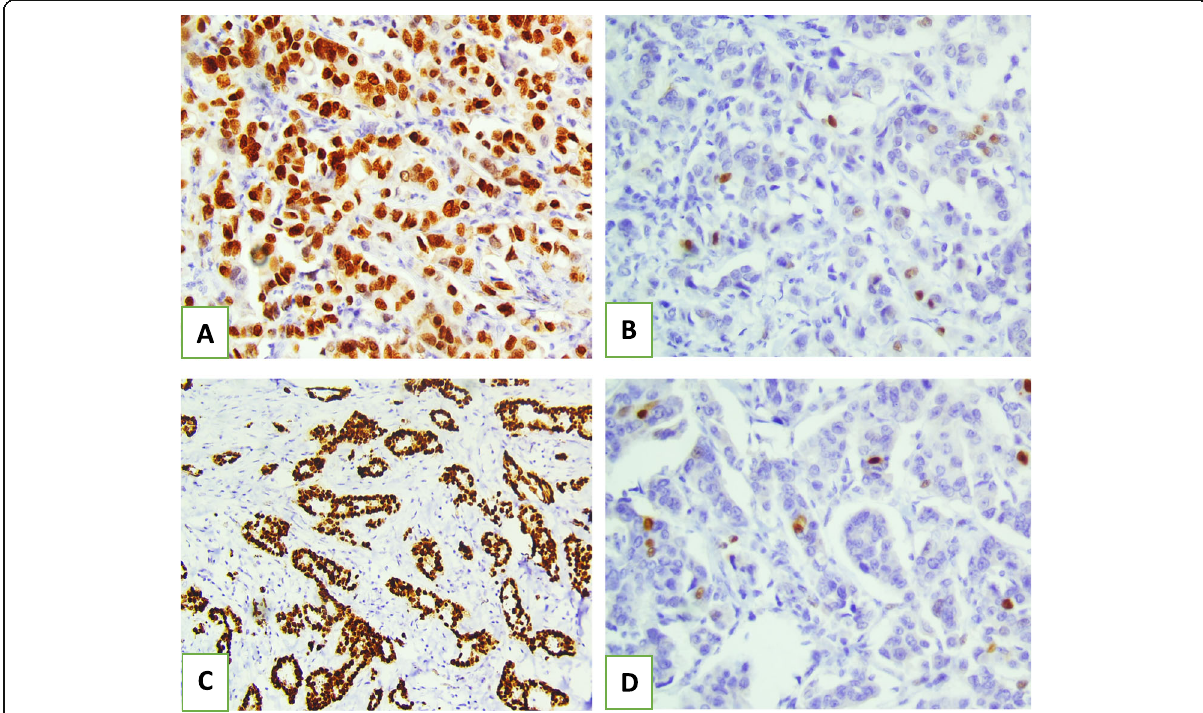
Fig. 1 Expression of DAXX and ATRX in tumor cells in invasive duct carcinoma. a High expression of DAXX in tumor cells (× 40). b Low expression of DAXX in tumor cells (× 40). c High expression of ATRX in tumor cells (× 20). d Low expression of ATRX in tumor cells (×